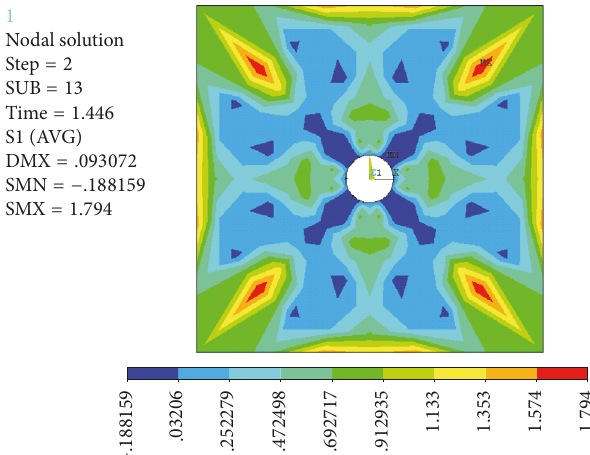
Figure 30: Principal tensile stress on the concrete specimen pre- stressed under a load of 10MPa when the displacement resulting from corrosion-induced expansion reaches 0.022 mm.